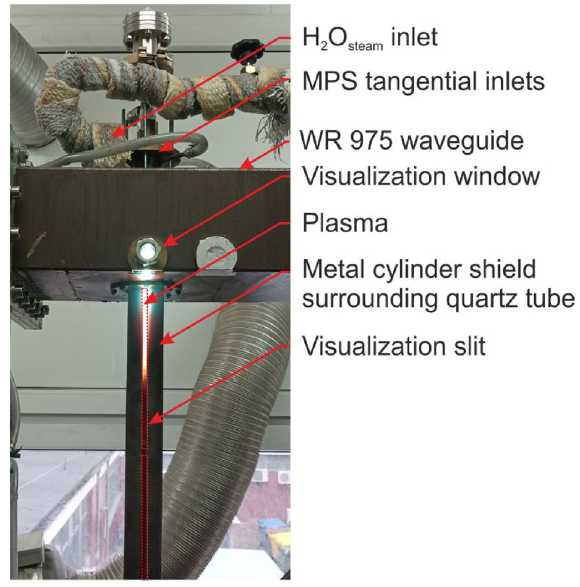
Figure 3. Photo showing the microwave plasma source (MPS) and the microwave plasma in the quartz